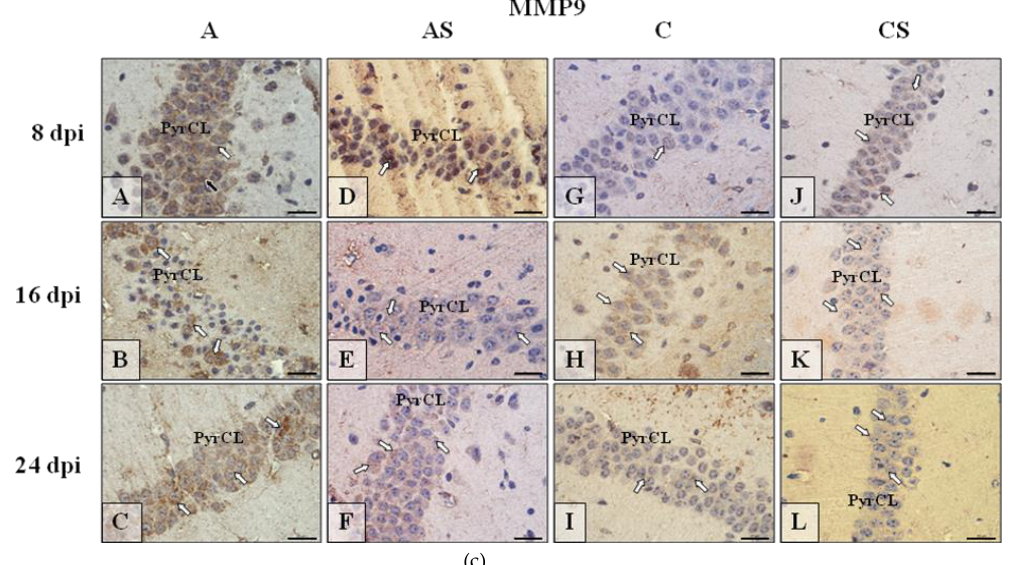
Figure 6. ( a ) Representative microphotography showing immunoexpression (brown color) of matrix metalloproteinases-9 (MMP-9) in the neocortex of mice from control group (a, G–I), immunosuppressed uninfected control group (a, J–L), immunocompetent infected by Acanthamoeba spp. (a, A–C) and immunosuppressed Acanthamoeba spp. infected group (a, D–F) in 8, 16 and 24 day post infection (dpi). White arrows show immunoexpression of MMP9 in the neurons of cerebral cortex. ( b ) Representative microphotography showing immunoexpression (brown color) of MMP-9 in the neurons of granular cell layer (GCL) of gyrus dentatus of mice from control group (6b, G–I), immunosuppressed uninfected control group (b, J–L), immunocompetent infected by Acanthamoeba spp. (b, A–C) and immunosuppressed Acanthamoeba spp. infected group (b, D–F) in 8, 16, and 24 dpi. White arrows show immunoexpression of MMP-9 in the neurons of that region of hippocampus. White asterisk, in some cases, shows tendency to immunolocalization of MMP-9 in basal region of GCL. c) Representative microphotography showing immunoexpression (brown color) of MMP-9 in neurons of pyramidal cell layer (PyrCL) of cornu ammonis of mice from control group (c, G–I), immunosuppressed uninfected control group (c, J–L), immunocompetent infected by Acanthamoeba spp. (c, A–C) and immunosuppressed Acanthamoeba spp. infected group (c, D–F) in 8, 16, and 24 dpi. White arrows show immunoexpression of MMP-9 in neurons of that region of hippocampus. Objective magnification a – c : ×100. Scale bar = 20μm.